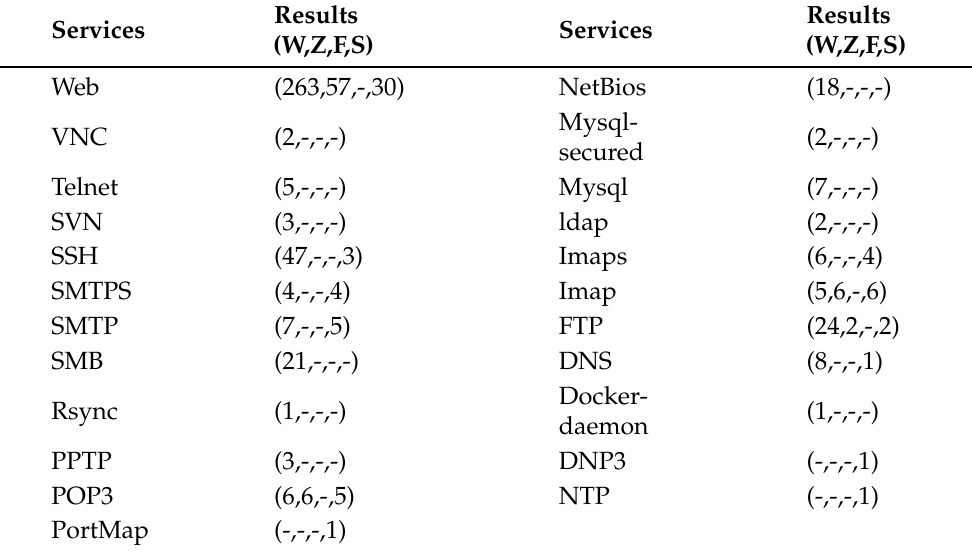
Table 11. Results of port service detection by WebHunt, Zoomeye, FOFA and